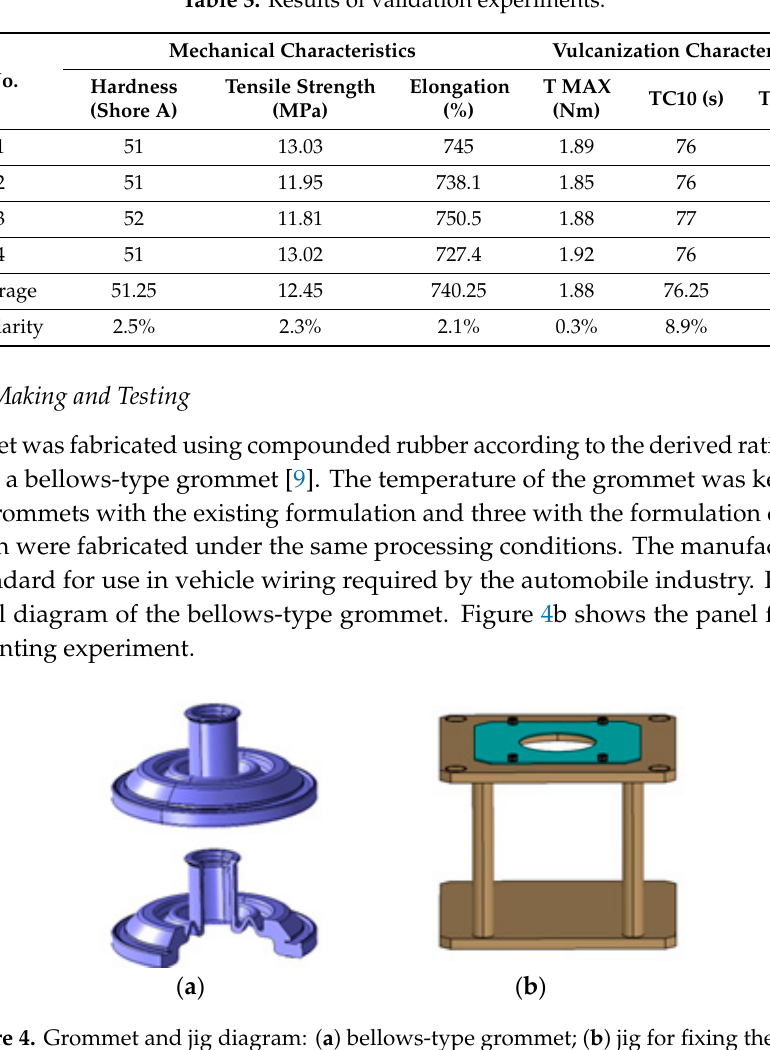
(b) Figure 5. Measurement of the insertion and separation forces: ( a ) depicts the measurement of the insertion force; ( b ) shows that of the separation force. 4. Analysis of Grommet Mountability 4.1. Result Analysis Figure 6 shows that the insertion force and the separation force of the newly manufactured grommet were reduced compared to the conventional grommet, and the value satisfies the reference value. Figure 6a shows that the average maximum insertion force was 114.98 N in the case of the conventional grommet—16.98 N higher than the reference value of 98 N. In the case of the grommets fabricated using the optimized compounding ratio, the maximum load average was 65.33 N, which was lower than the standard by 32.67 N. This means that the mounting performance improved when the grommet was inserted into the panel. In addition, Figure 6b shows a measurement graph of the separation force. The average maximum load of the separation force decreased from 160.06 N for the conventional grommet to 96.67 N for grommets fabricated using the optimized compounding ratio, which is higher than the reference value of 69 N.